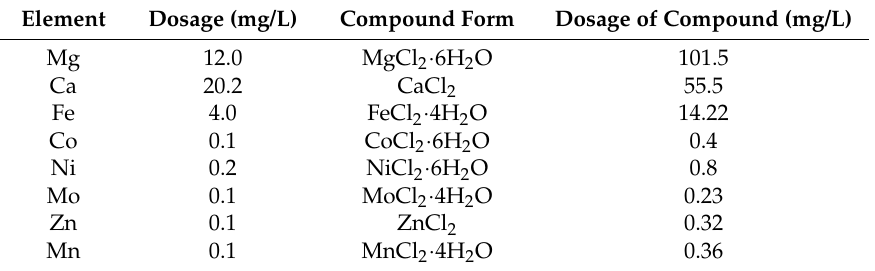
Table 1. Dosage of trace